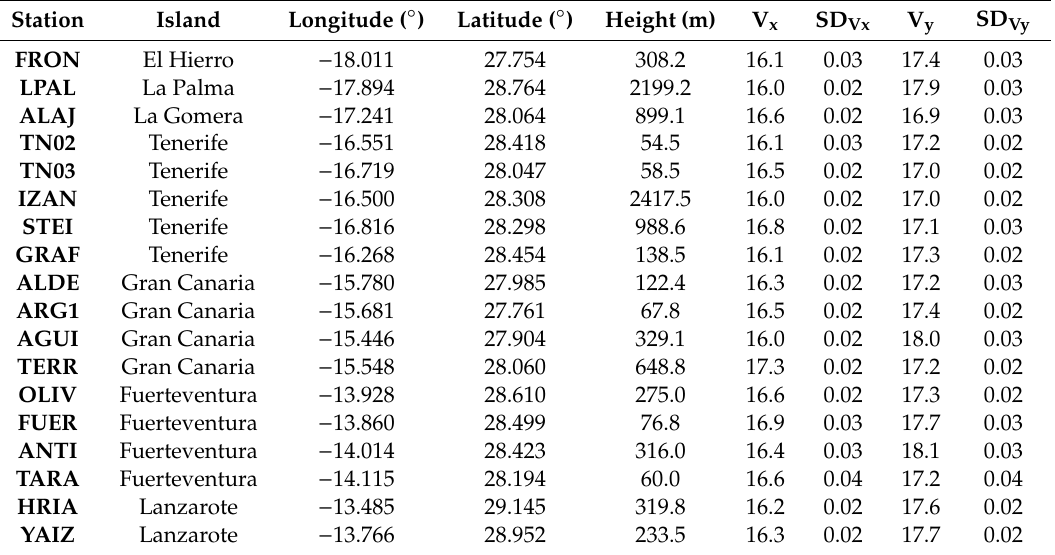
Table 1. Geographic coordinates of the GNSS stations employed in this study. Horizontal velocities (V x , V y ) and standard deviations (SD Vx , SD Vy ) after filtering out the common-mode bias. Velocity and standard deviation units are mm /